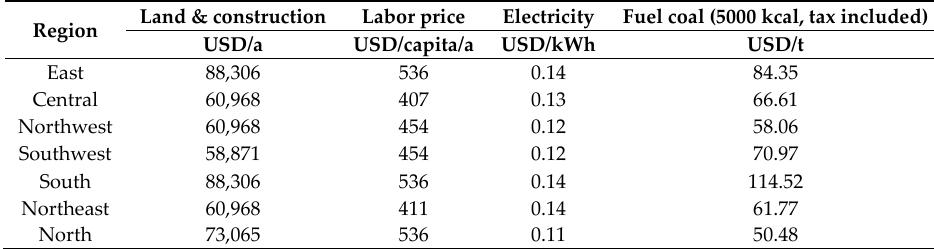
Table 6. Regional data.